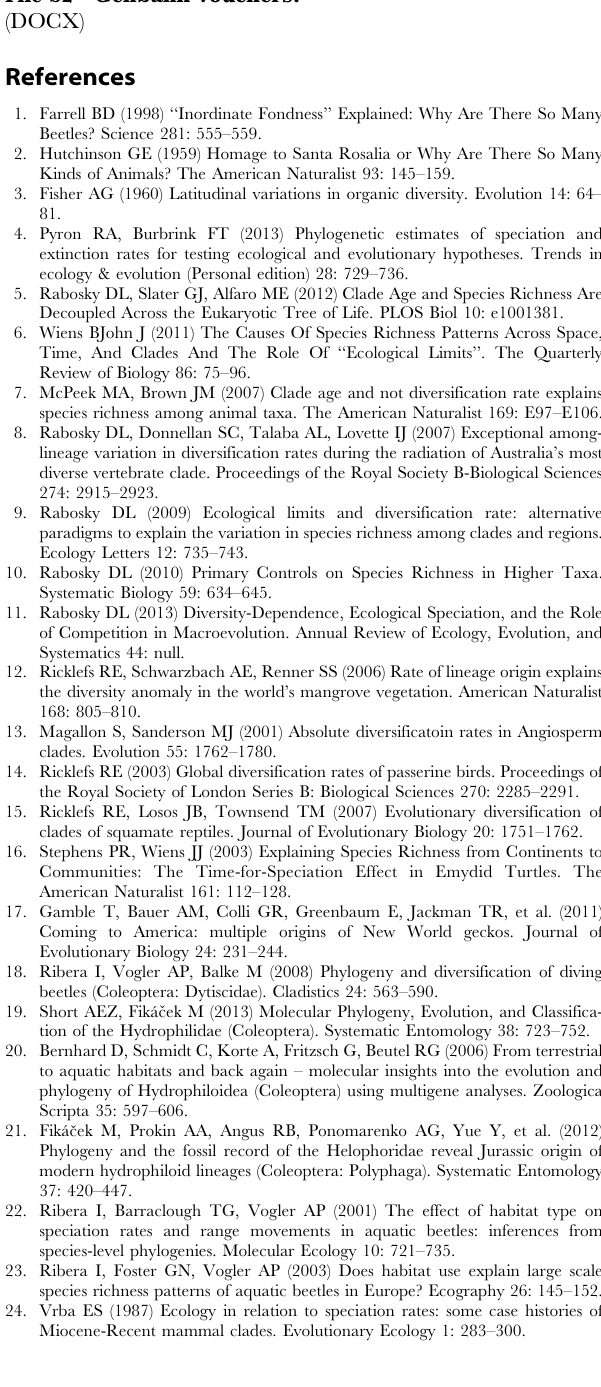
Figure S1 Hydrophilidae time tree uniform priors. (PDF) Figure S2 Hydrophilidae time tree exponential priors. (PDF) Figure S3 Hydrophilidae time tree with posterior support